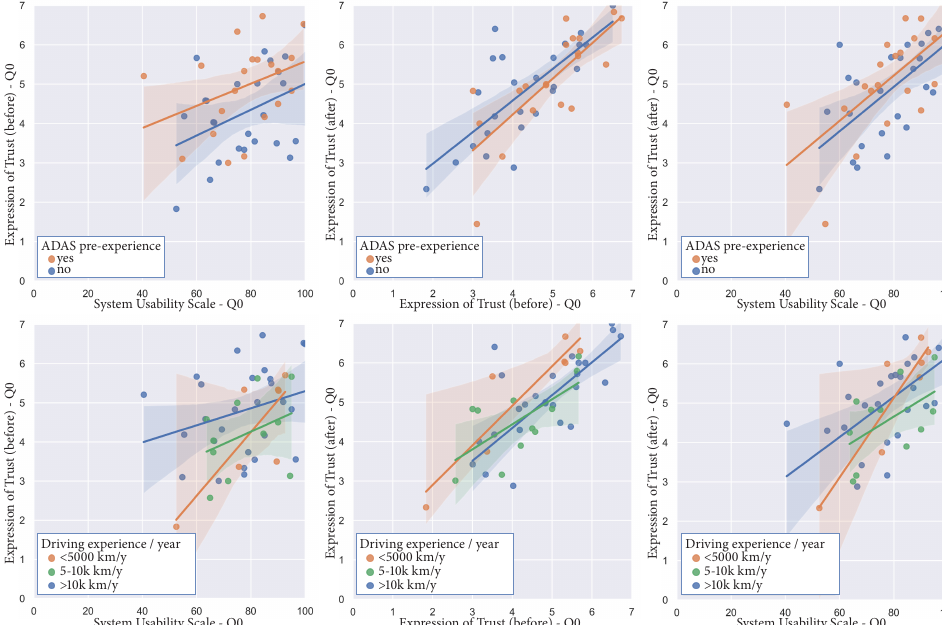
Figure 11. Pearson correlations with descriptive analysis of potential clusters regarding ADAS pre-experience and driving